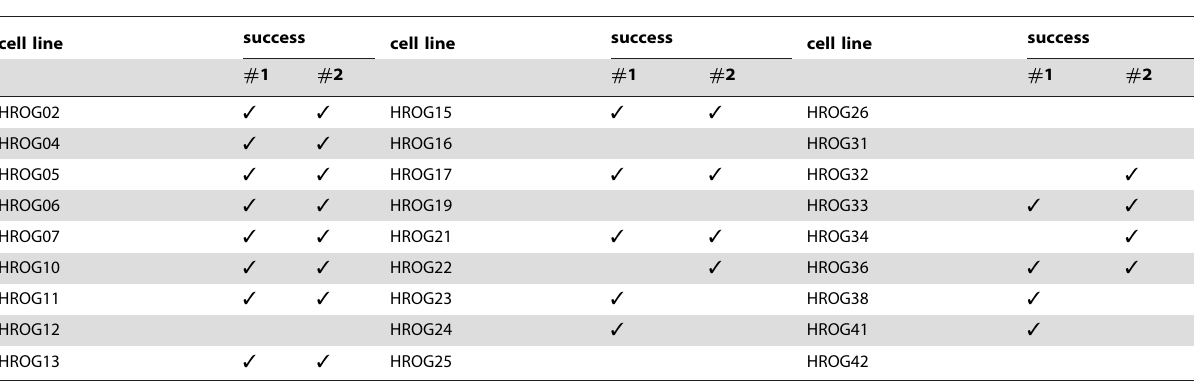
Table 3. Success rates of in vitro models.